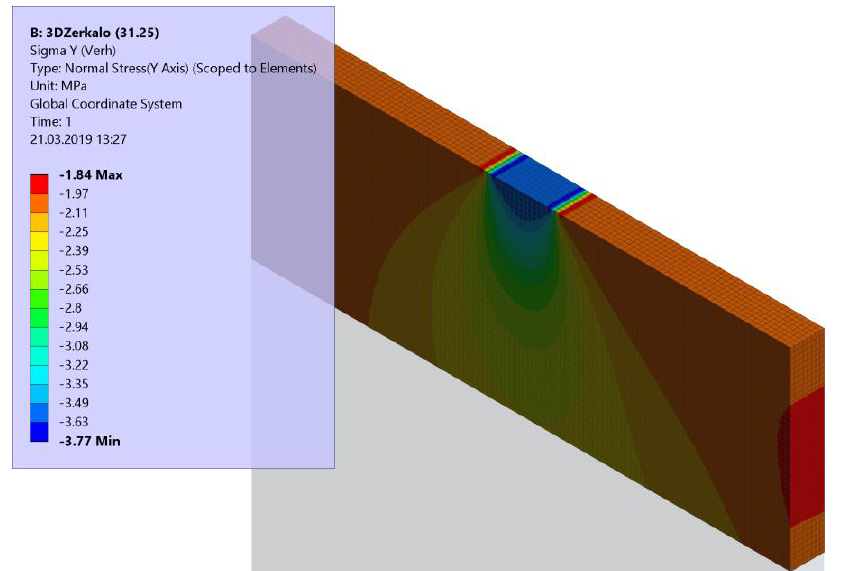
Fig. 3. Distribution of stress σ y in the upper part of the deep beam